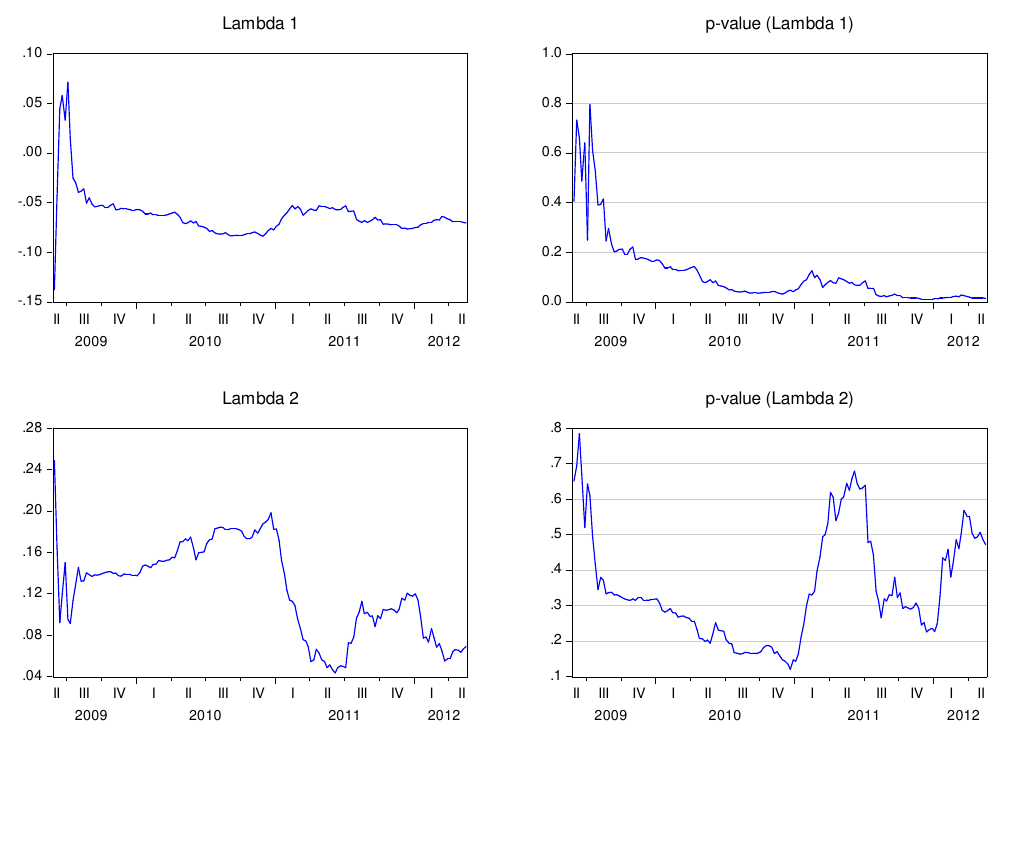
Figure 4. Recursive estimation of the speed adjustment parameters — France.